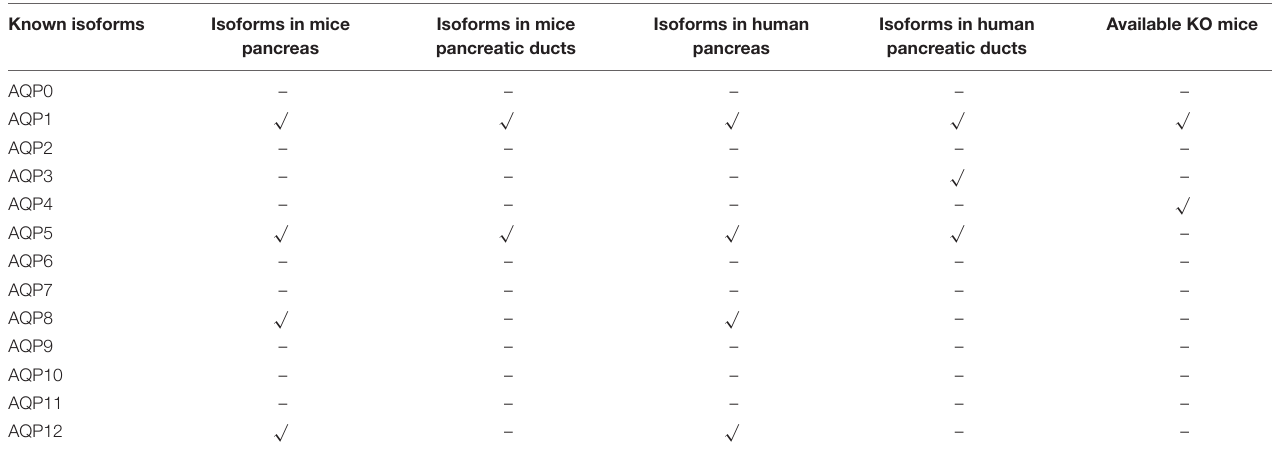
FIGURE 2 | Pancreatic ductal HCO 3 − and fluid secretion in AQP1 knock out mice. (A) Traditional PCR shows the presence of AQP1 mRNA both in the isolated pancreatic ducts (PD) and in the total pancreas (TP). As positive control, kidney was used (K). (B) Pancreatic ductal fluid secretion was measured on isolated pancreatic ducts from wild type (WT, black line) and AQP1 knock out (KO, red line) mice. Changes in the relative luminal volume of the ducts was measured by videomicroscopy and analyzed by Scion Image software. (C) Changes in the relative luminal volume of the pancreatic ducts of AQP1 WT and KO mice measured at the final time point (40 min). Data are shown as means ± SEM. n = 4–8 ducts/groups. ∗ p ≤ 0.05 vs. WT. (D) Reconstructed images of the duodenal filling before (1) and after (2) secretin stimulation. Yellow color shows the presence of fluid. Red arrows indicate excreted volume in the small bowel after stimulation with secretin. In the case of KO mice, the secretin-stimulated fluid secretion significantly decreased. (E) In vivo pancreatic fluid secretion was measured as total excreted volume (TEV) using small animal magnetic resonance imaging. Raw data were acquired in axial and coronar view. Data are shown as means ± SEM. n = 4 animals/groups. ∗ p ≤ 0.05 vs. WT. (F) Representative experimental traces show pancreatic ductal HCO − secretion in AQP1 WT (black line) and AQP1 KO (red line) mice. (G) Base 3 flux [– J (B − /min)] was calculated from the (cid:49) pH/ (cid:49) t obtained by linear regression analysis of pH i measurements made over the first 60 s after readdition of extracellular Cl − . Means ± SEM are from 20 ROIs of four ducts. ∗ p ≤ 0.05 vs. WT. TABLE 2 | mRNA expression of AQP isoforms in mice and